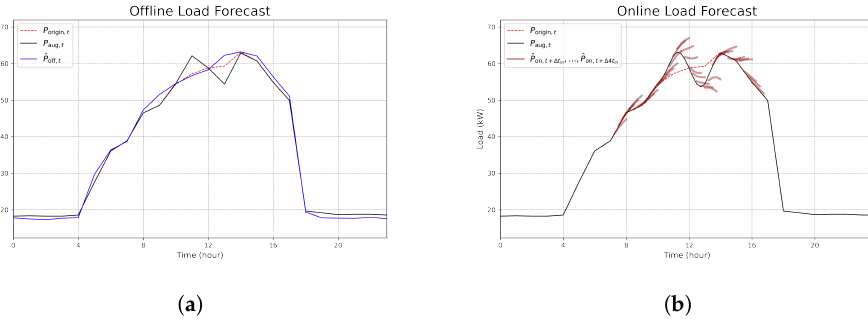
Figure 10. Offline and online load forecasts with sign indefinite synthetic uncertainties.( a ) Offline load forecast, ( b ) Online load forecast.